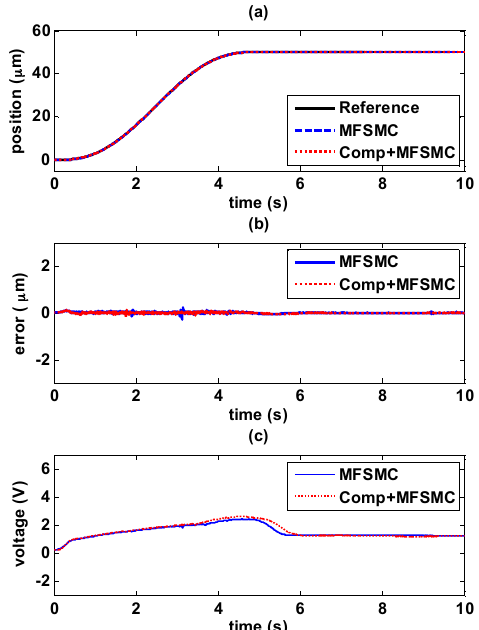
Figure 21. Tracking control comparisons of 5th order trajectory between using PID path controller solely and PID path controller with the hysteresis compensator: ( a ) path tracking responses; ( b ) control errors; ( c ) control signals.